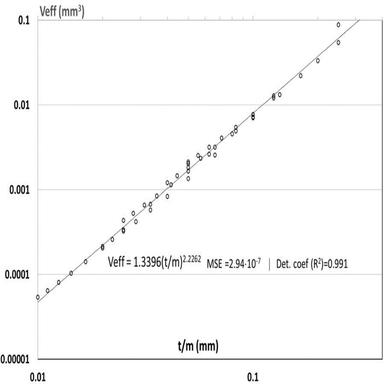
Effective volume, Veff, calculated by FEM, versus the relation between the specimen thickness and the Weibull modulus, t/m (log-log coordinates).